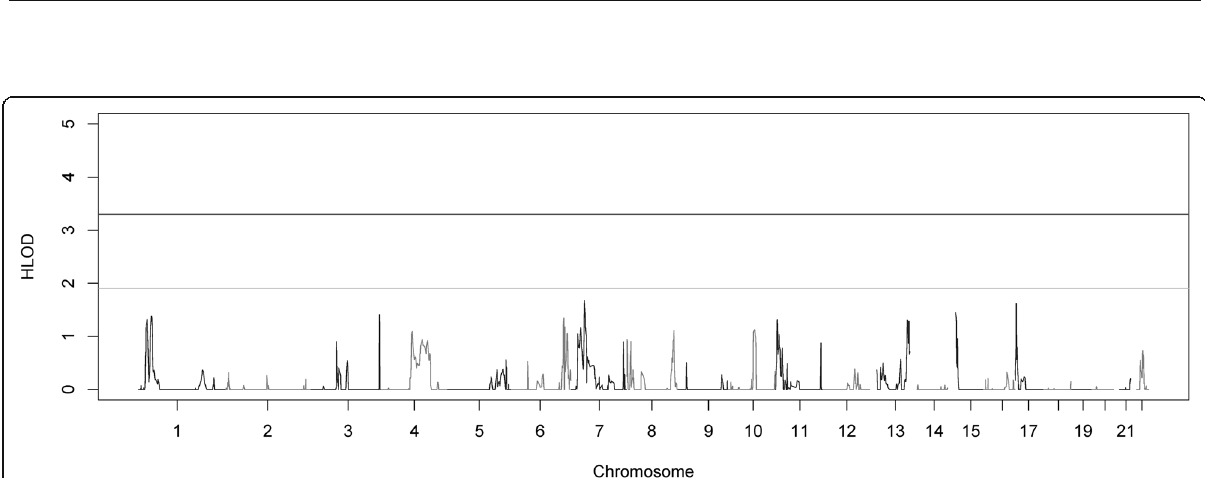
Fig. 2 Chromosomal plots of two-point heterogeneity (HLOD) scores produced across the 64 Ashkenazi families. a . Plot of chromosome 1 in cM. b . Plot of chromosome 8 in cM. In both plots, the lines at 1.9 and 3.3 represent the respective suggestive and significant thresholds recommended by Lander and Kruglyak